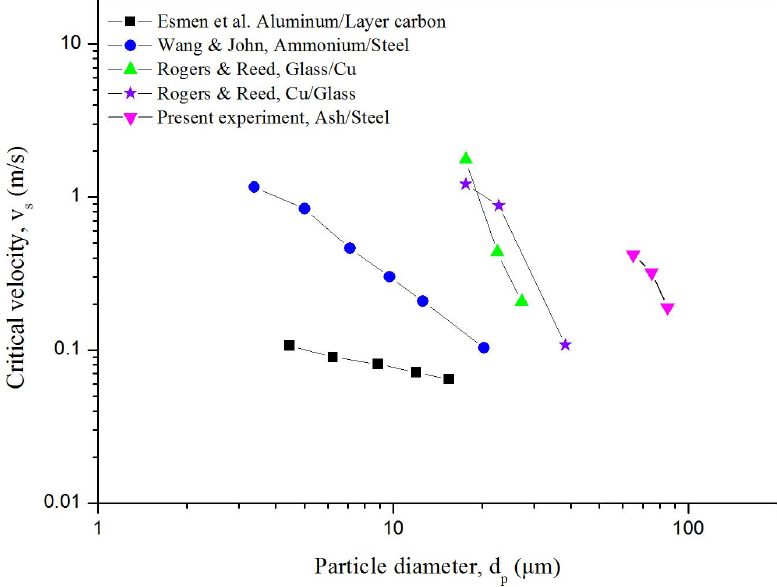
Figure 12. Comparison of available data relating critical velocity to particle